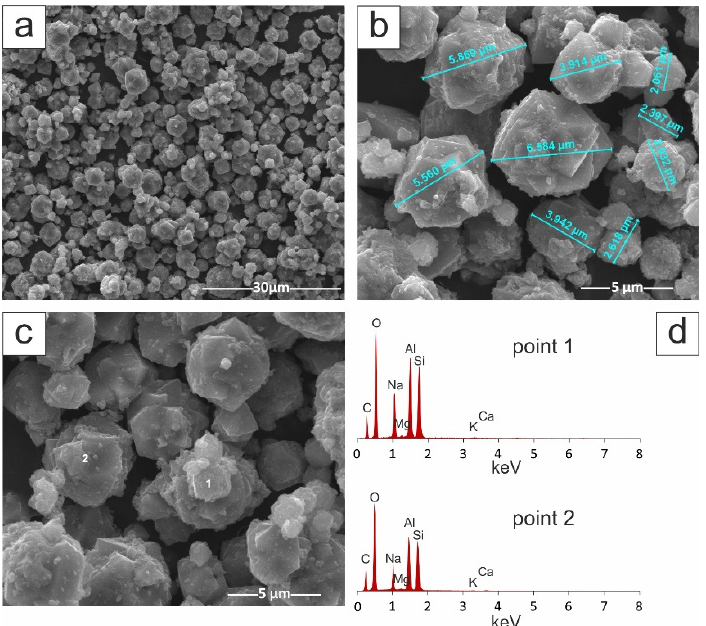
Figure 3. SEM images of Na-X sample: ( a ) 4000× magnification, ( b ) 16,000× magnification, ( c ) 16,000× magnification with EDS chemical analysis ( d ). ( c ) 16,000 × magnification with EDS chemical analysis ( d ).